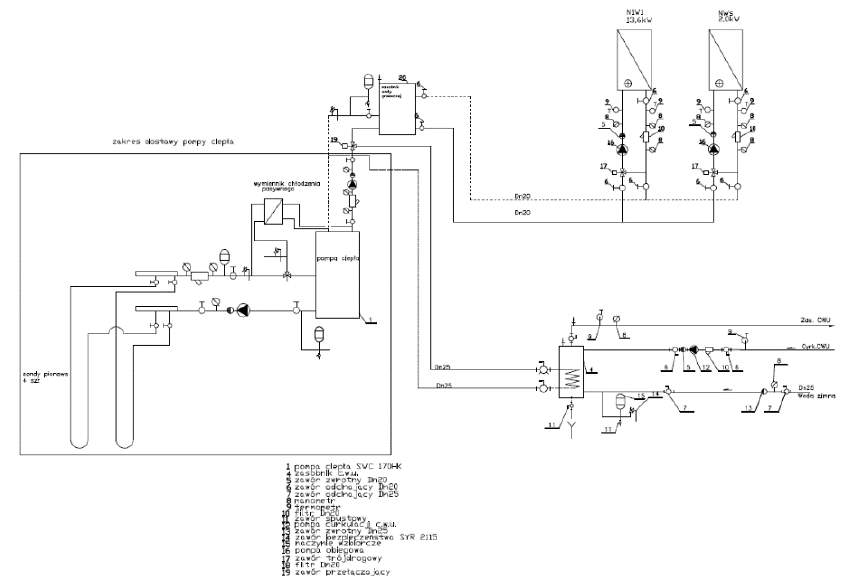
Figure 4. Diagram of the boiler room according to the school’s installation project [35].